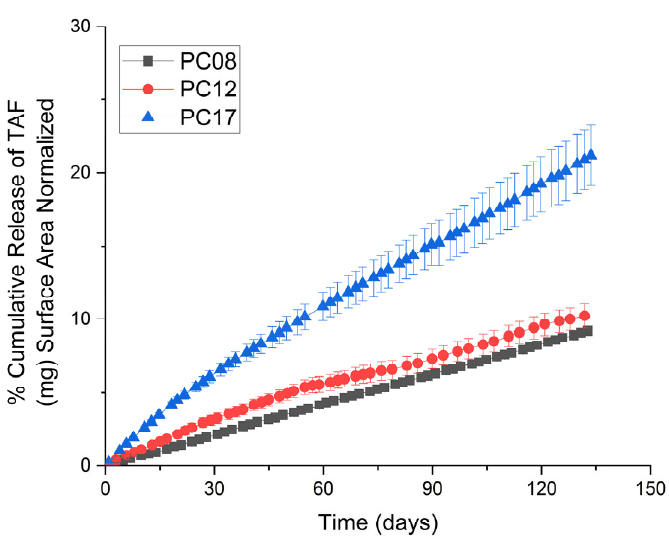
Figure 2. Cumulative release profiles of TAF from implants comprising extruded tubes of PC-08,